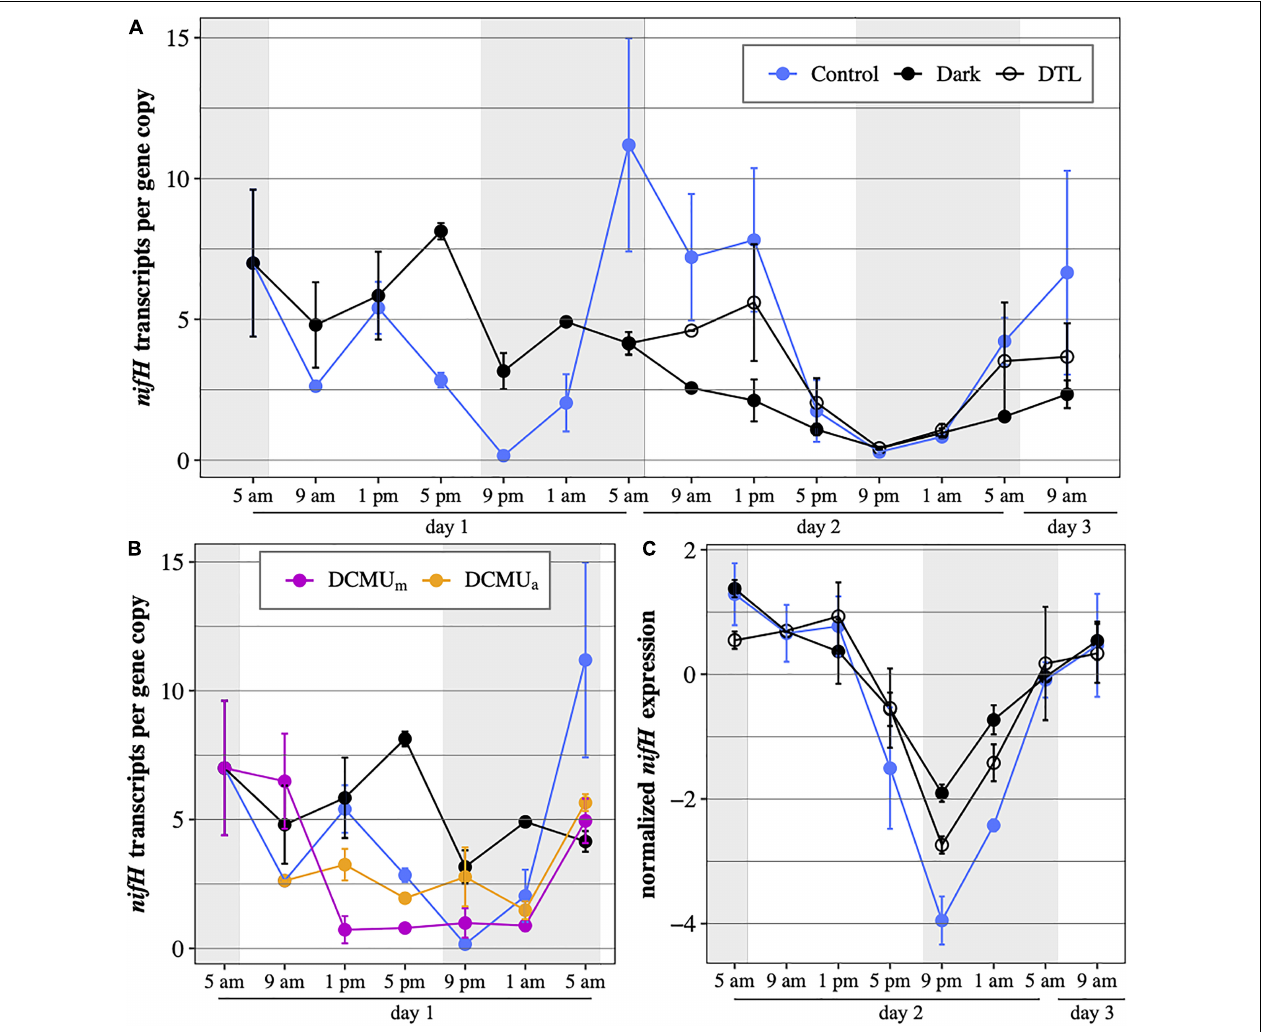
FIGURE 4 | UCYN-A2 nifH gene expression in transcripts per gene copy, (A) during the full 52-h experiment in control incubations (blue), incubations returning to normal light-dark conditions after spending the first 24 h (DTL, open circles) or the first 48 h (Dark, black) of the experiment in the dark and (B) during the first 24 h of the experiment in control incubations (blue), dark incubations (black) and incubations exposed to DCMU added at 5 a.m. (purple) or at 1 p.m. (orange). (C) normalized UCYN-A2 nifH gene expression during the last 28 h of the experiment in control (blue), dark (black), and DTL (open circles) incubations. Expression levels were normalized to the median expression over that period within each condition and log 2 -transformed. Mean ± SD of biological duplicates are shown. Shaded areas represent